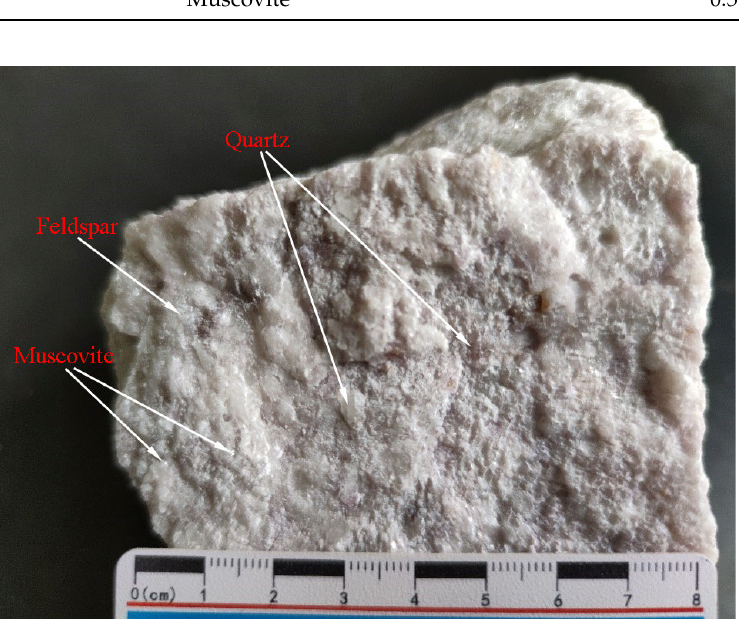
Figure 3. Hand specimens of the ore. (The ore is gray–white with a massive and coarse-grained structure. Coarse feldspar and quartz particles, and glassy muscovite particles are visible.).